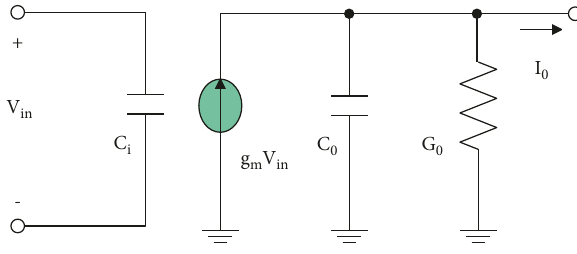
Figure 5: POTA small-signal equivalent